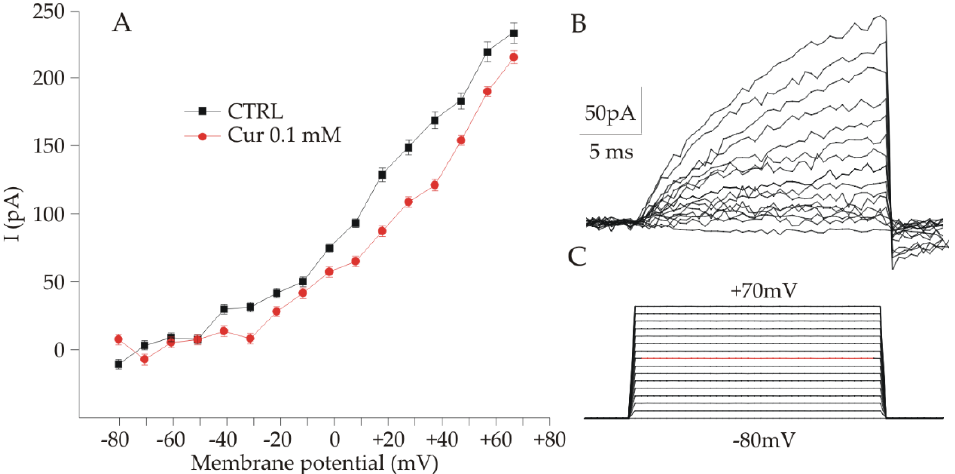
Figure 6. Voltage activated currents recorded in ARPE-19 cells CTRL and Cur 0.1 mM. ( A ) The currents obtained for each potential step were averaged and plotted against the respective voltage to obtain a current-voltage curve for control and curcumin treated cells. ( B ) Representative profiles of the currents obtained for each voltage steps shown in panel ( C ). ( C ) Plot of the voltage steps of 10 mV from − 80 to +70 mV administered to the cell, the red line indicates 0 mV. The two curves shown in panel A are not different as assessed by the Kolmogorov-Smirnov test, suggesting that curcumin does not affect the functional properties of ARPE-19 cells.